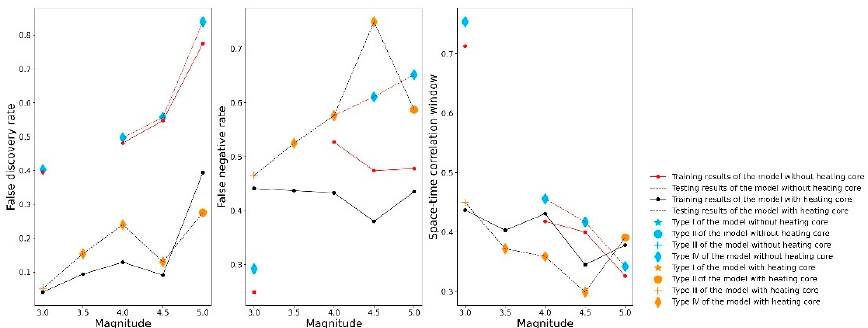
Figure 11. The optimal parameters of the models with/without a “heating core” when the moving window scale is 100 under different magnitude parameters.